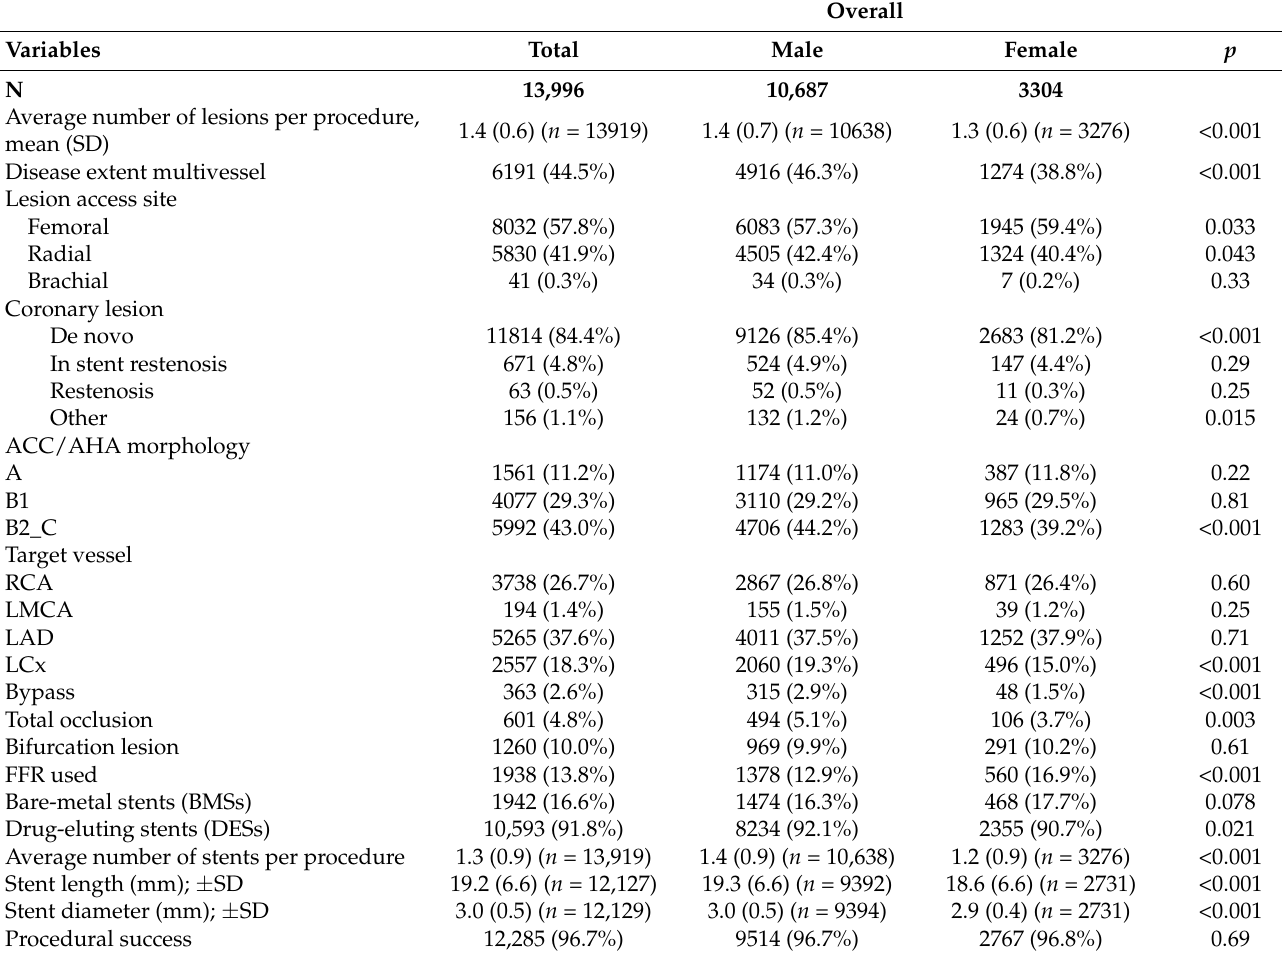
Table 2. Procedural characteristics by